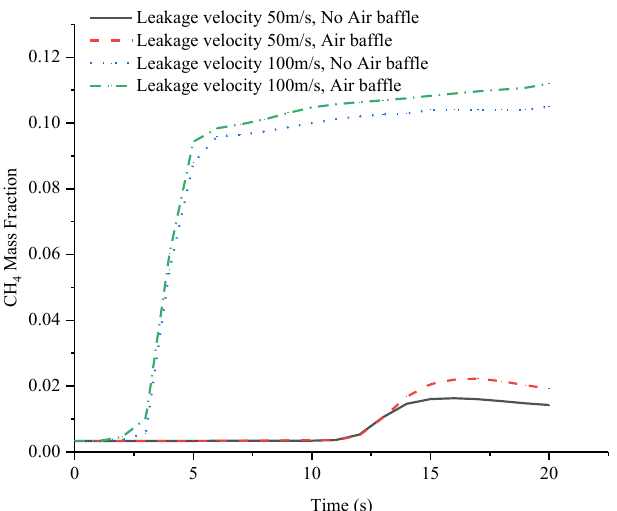
Figure 5. CH 4 concentration versus time at monitoring points under normal ventilation conditions. (3) Effect of the baffles at different heights of the gas baffle According to the requirements of the relevant standards and specifications for the installation of obstructions and air intake and exhaust in the tunnel cabin, and taking into account the usual operation and maintenance and personnel activities, Huang et al. vided a range of 0.4, 0.5, and 0.6 m for the height of the air baffle. In order to investigate air baffle was adjusted to 0. 3 m, 0.5 m, and 0.7 m in order to simulate and analyse the situation with a ventilation wind speed of 0 m/s and a leakage velocity of 50 m/s. The variation of CH 4 concentration at the monitoring point with time for different baffle heights was obtained, as shown in Figure 6 .